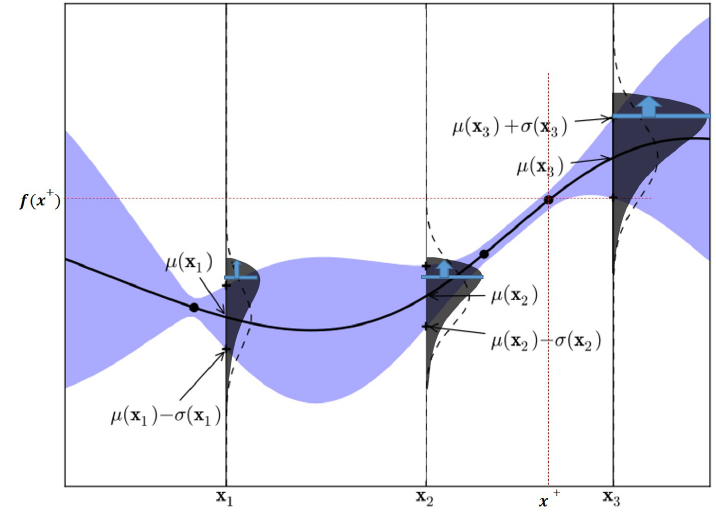
Figure 3. An example of region of probable improvement using a Gamma Distribution [24]. The maximum observation is x + . In the overlapping Gaussian, over the dotted line, the dark shaded area can be used as a measure of improvement, I ( x ) . In this model, sampling at x 3 is